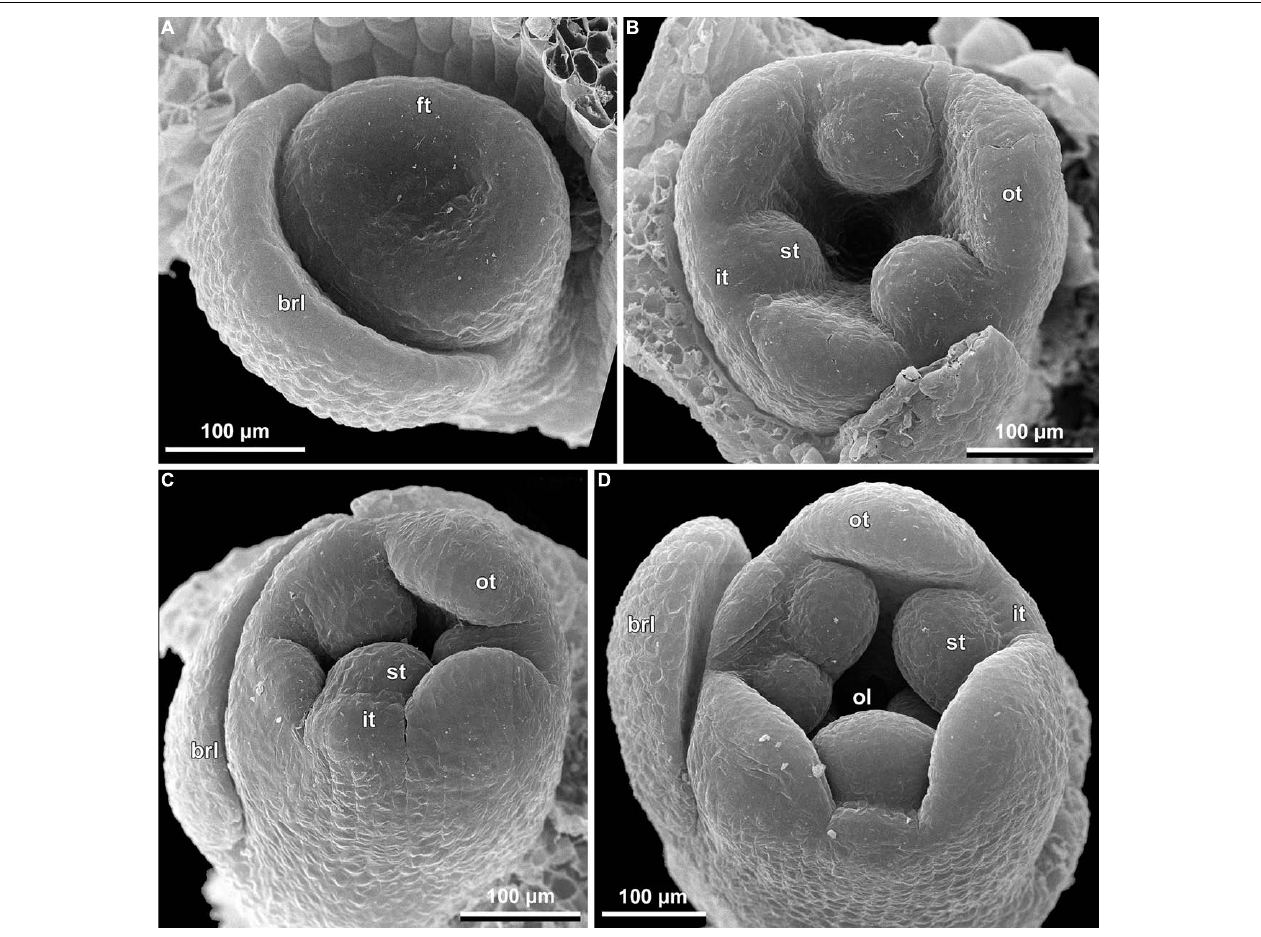
FIGURE 13 | Early floral development of Burmannia itoana (SEM). (A) Flower at initiation of floral tube. (B,C) Flower at initiation of inner tepal lobes and stamens on their common primordia; in (C) one outer tepal lobe is smaller than the two others. (D) Flower at initiation of ovary locule; note the fourth (teratological) stamen. brl, bracteole; ft, floral tube; it, inner tepal; ol, ovary locule; ot, outer tepal; st,